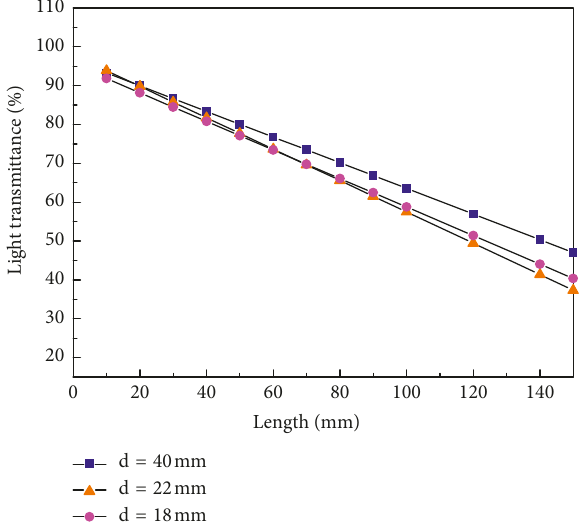
Figure 17: Relationship between the wavelength and transmitted light power of specimens with different lengths.